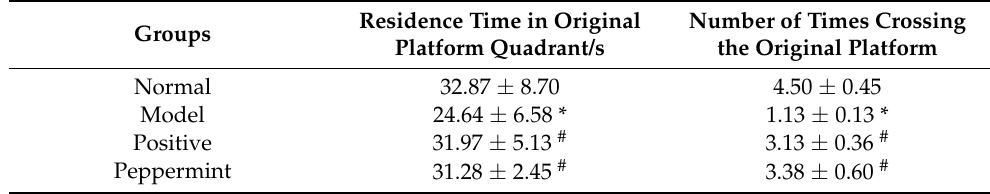
Table 2. Results of space exploration test (x ± S, n =